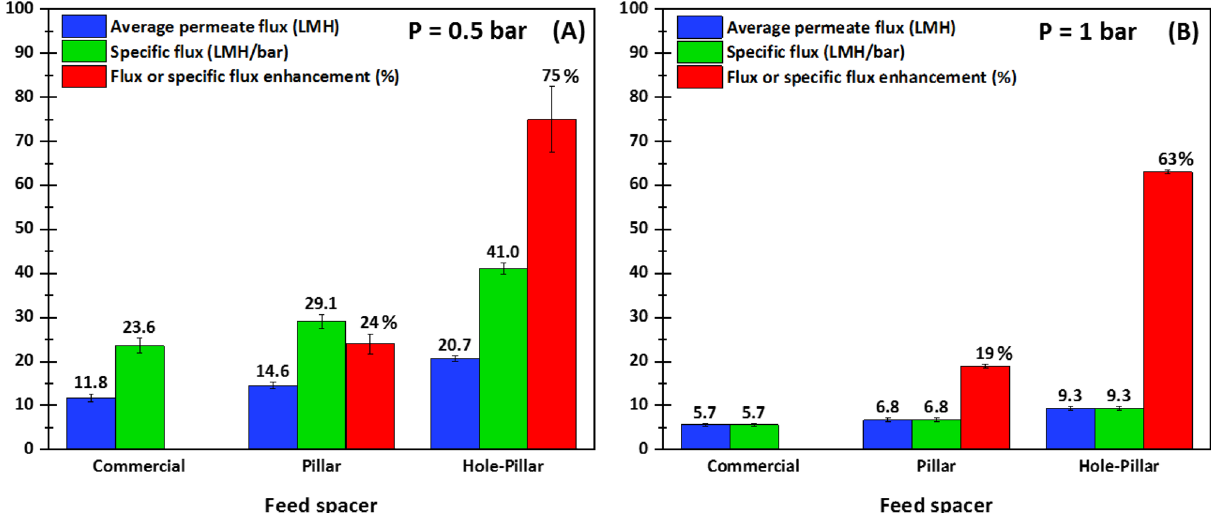
Figure 7. UF filtration performances at steady-state after 67 h of filtration process in presence of various tested spacers for two applied pressures: ( A ) P = 0.5 bar, and ( B ) P = 1.0 bar. The specific flux is determined relative to transmembrane pressure. The flux and specific flux enhancement were calculated relative to the commercial